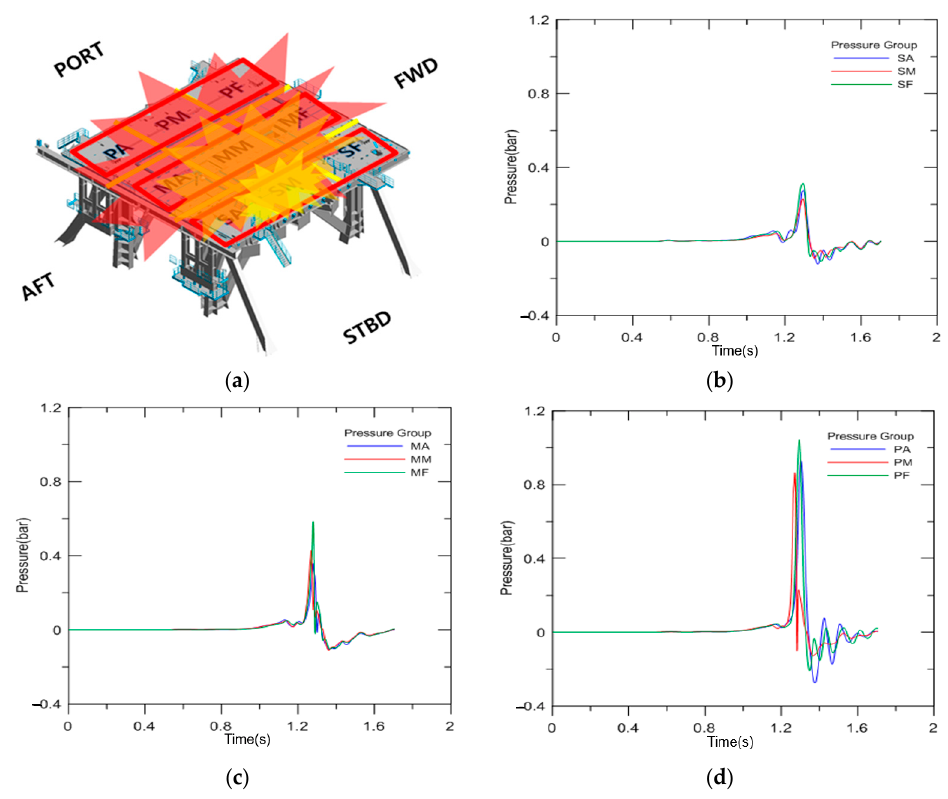
Figure 10. ( a ) Pressure group on the drill floor, ( b ) time history plot of blast pressure on group SA-SM-SF, ( c ) time history plot of blast pressure on group MA-MM-MF and ( d ) time history plot of blast pressure on group PA-PM-PF.